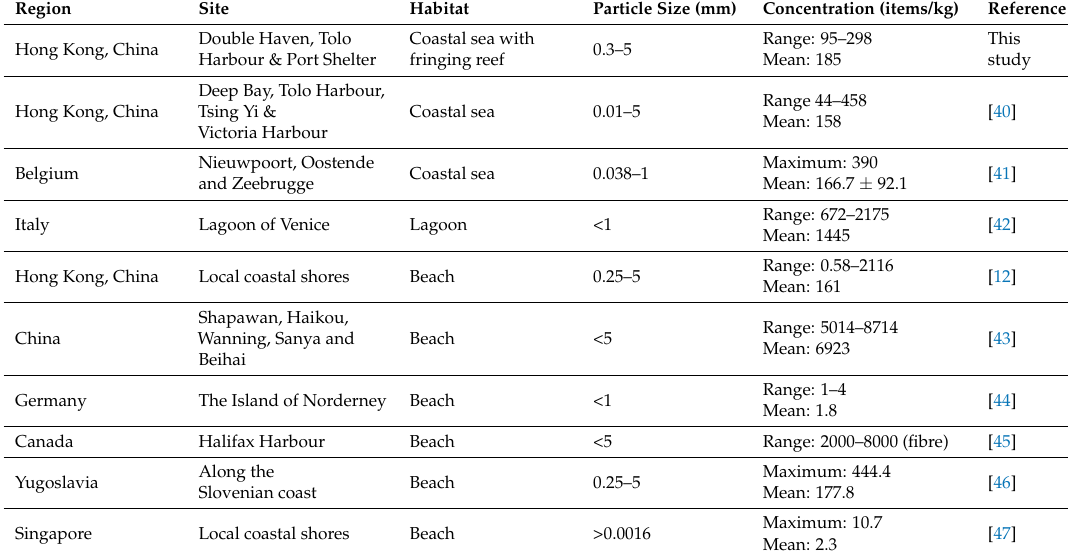
Table 2. Concentrations of microplastics in marine sediments of different regions. The units of the microplastic concentrations have been standardized to